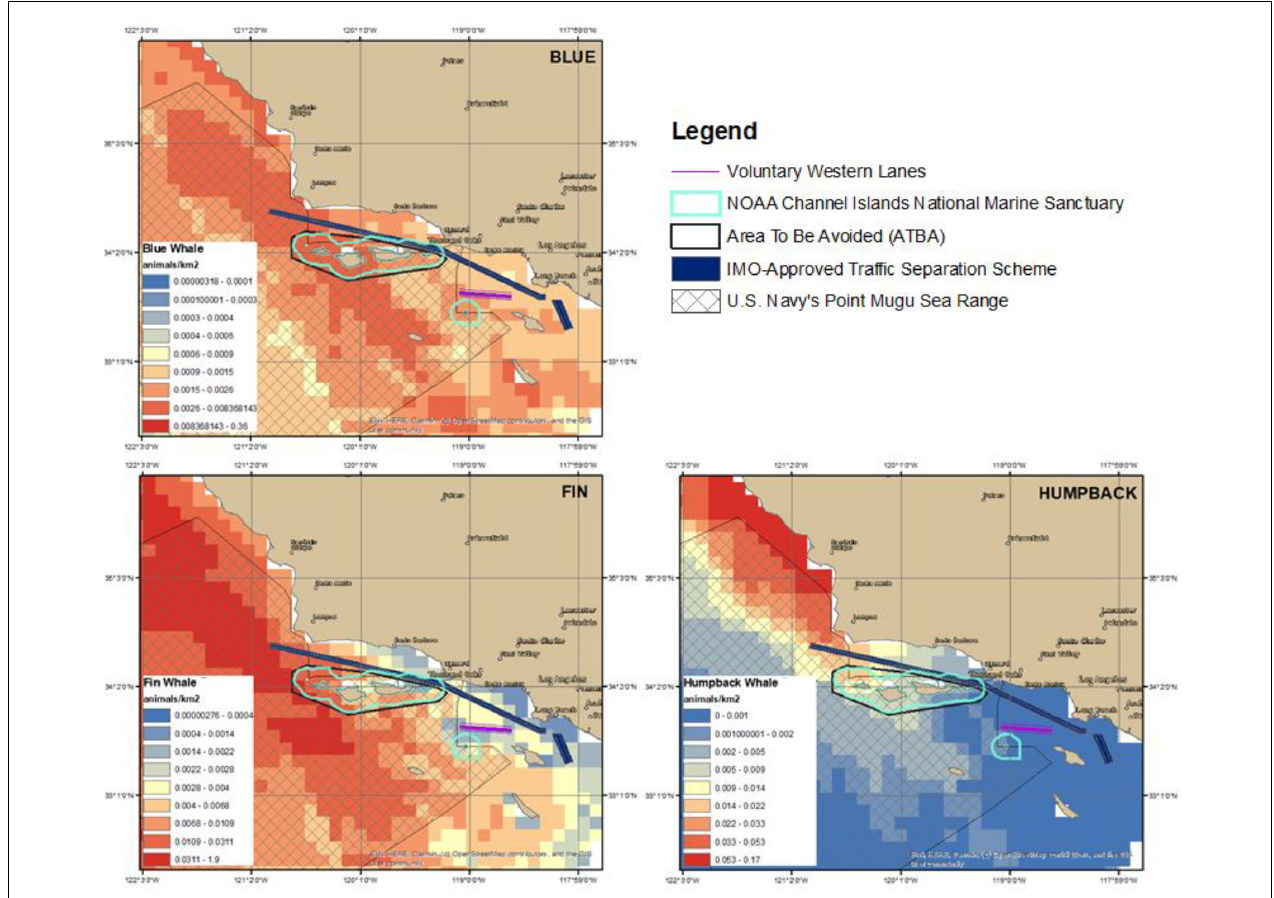
FIGURE 1 | Predicted density of blue, fin, and humpback whales from models produced by Becker et al. (2020) and existing management areas impacting vessel routing in the Southern California